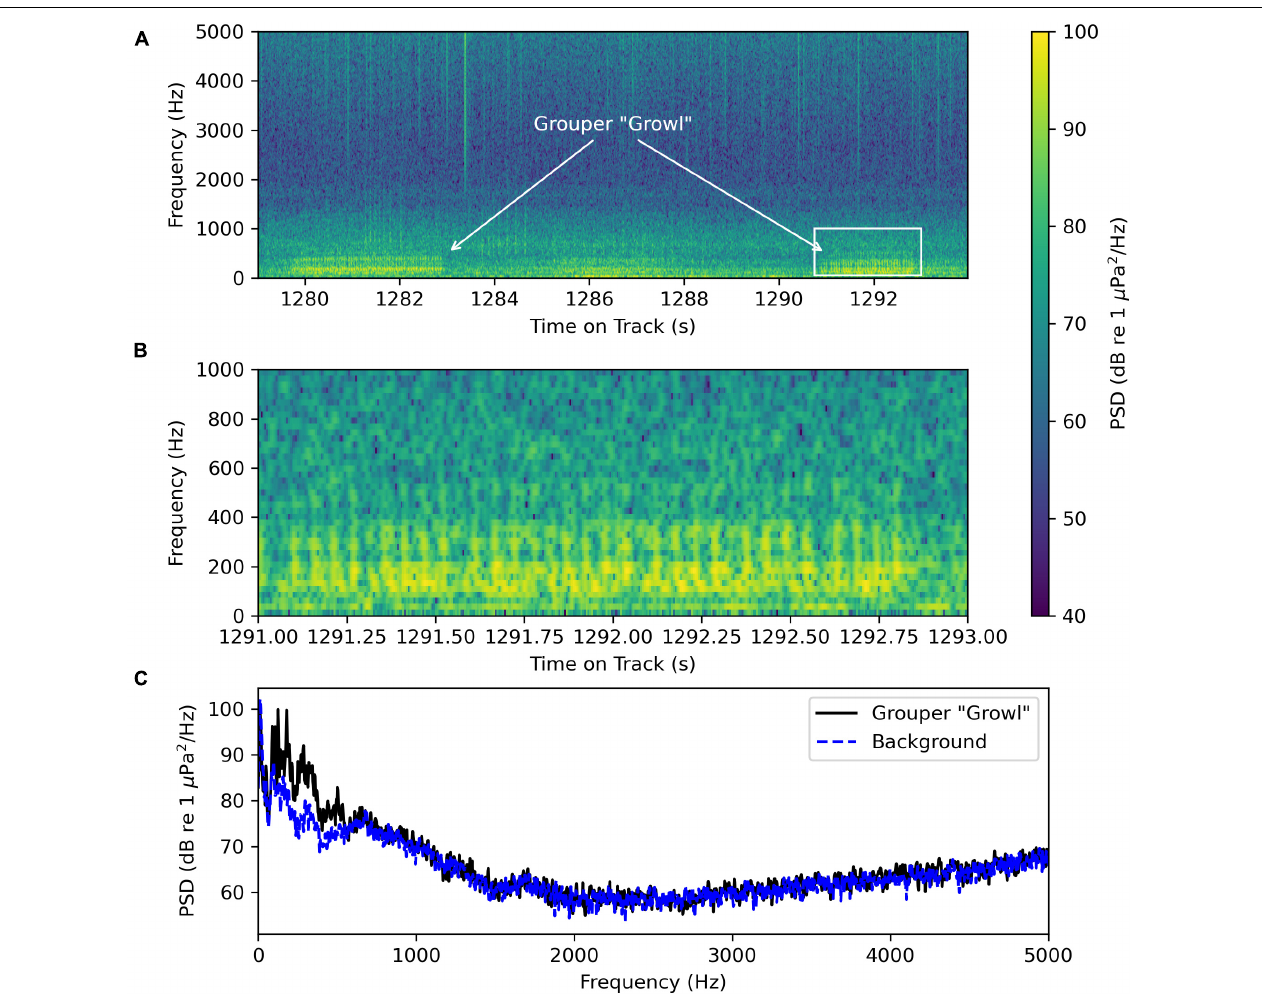
FIGURE 9 | Grouper “growl” sounds recorded by the wave glider Blackbeard at August-07 20:56:05 at latitude and longitude (34.494 632N, 77.009 573W). (A) Spectrogram of a 15 s segment of the recording containing two distinct “growl” sounds. (B) Spectrogram of the second “growl” sound in panel (A) outlined in the rectangle. (C) Average power spectrum for the “growl” sound shown in panel (B) from 1291.0 to 1293.0 s in the recording and the background noise from 1288.0 to 1290.5 s when there were no “growl” sounds detected. Both average power spectra were computed using 16 384-point Hanning windows with an overlap of 8192